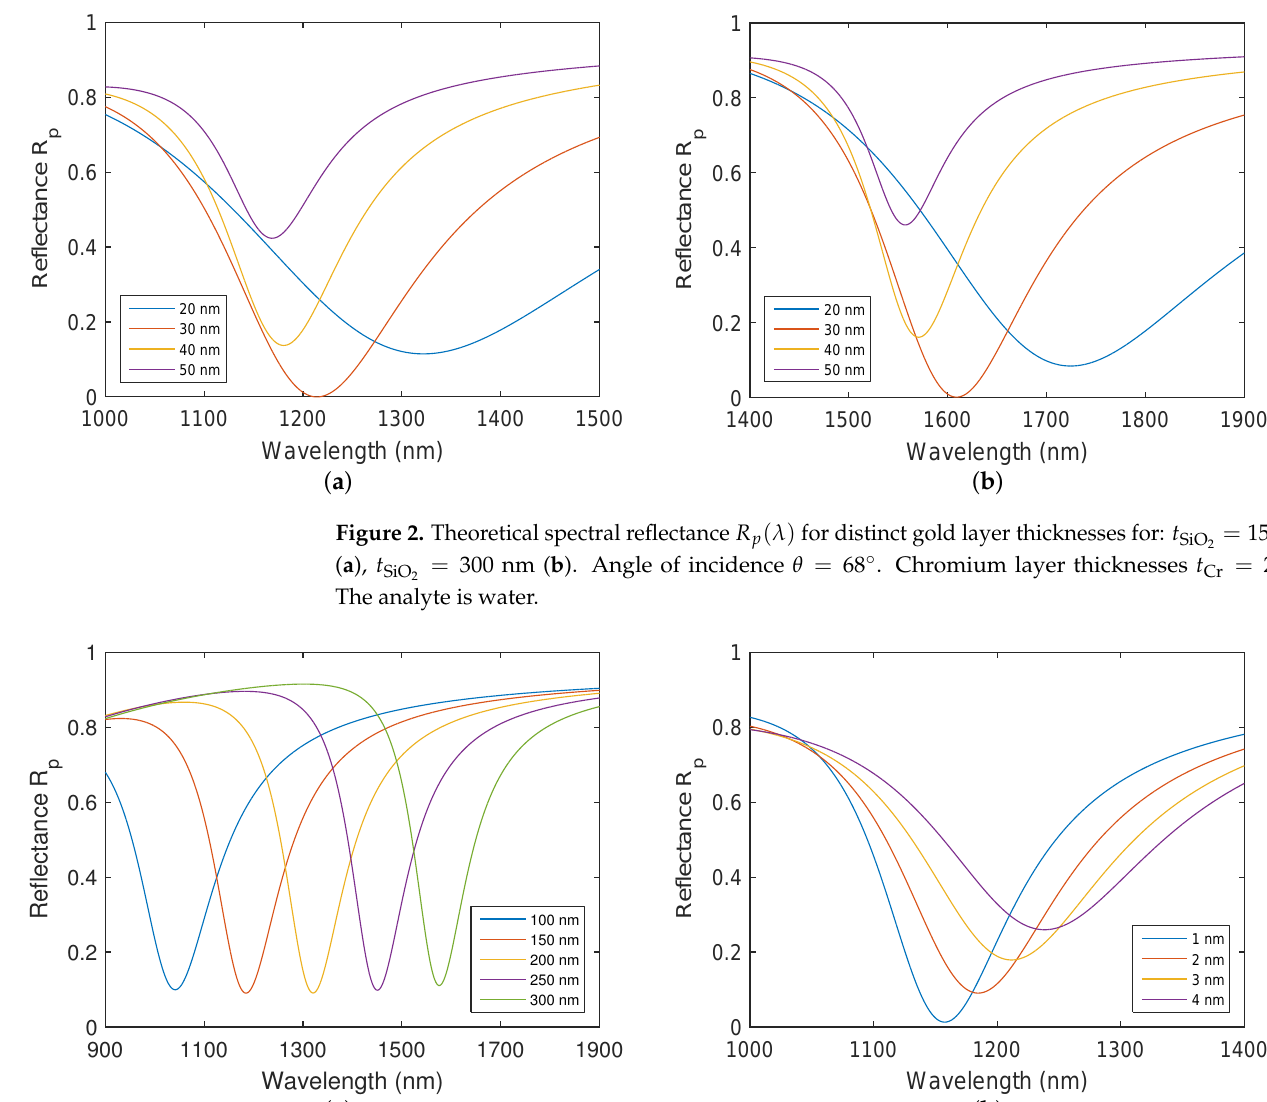
Figure 3. Theoretical spectral reflectance ratio R p ( λ ) for distinct silicon dioxide layer thicknesses ( a ) and for distinct adhesion chromium layer thicknesses ( b ). Gold layer thickness t Au = 38 nm. Angle of incidence θ = 68 ◦ . The analyte is